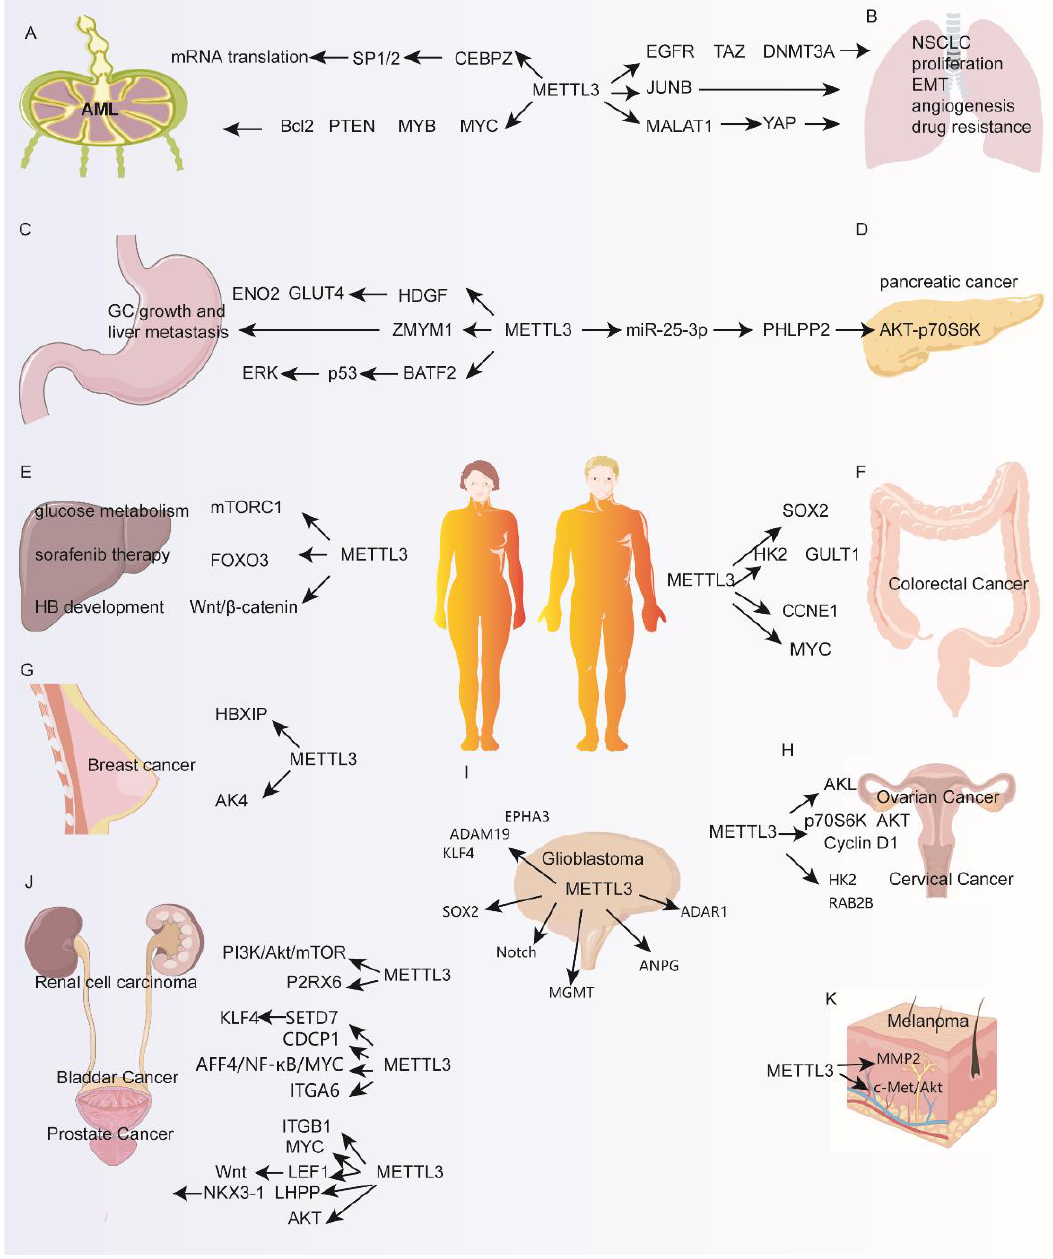
Figure 2. Multifaceted functions of METTL3 in different types of cancer. A – K propose how METTL3 regulates various genes and molecular pathways. AML, Acute myeloid leukemia; regulates various genes and molecular pathways. AML, Acute myeloid leukemia; NSCLC, non-small- NSCLC, non-small-cell lung carcinoma; GC, Gastric cancer. cell lung carcinoma; GC, Gastric